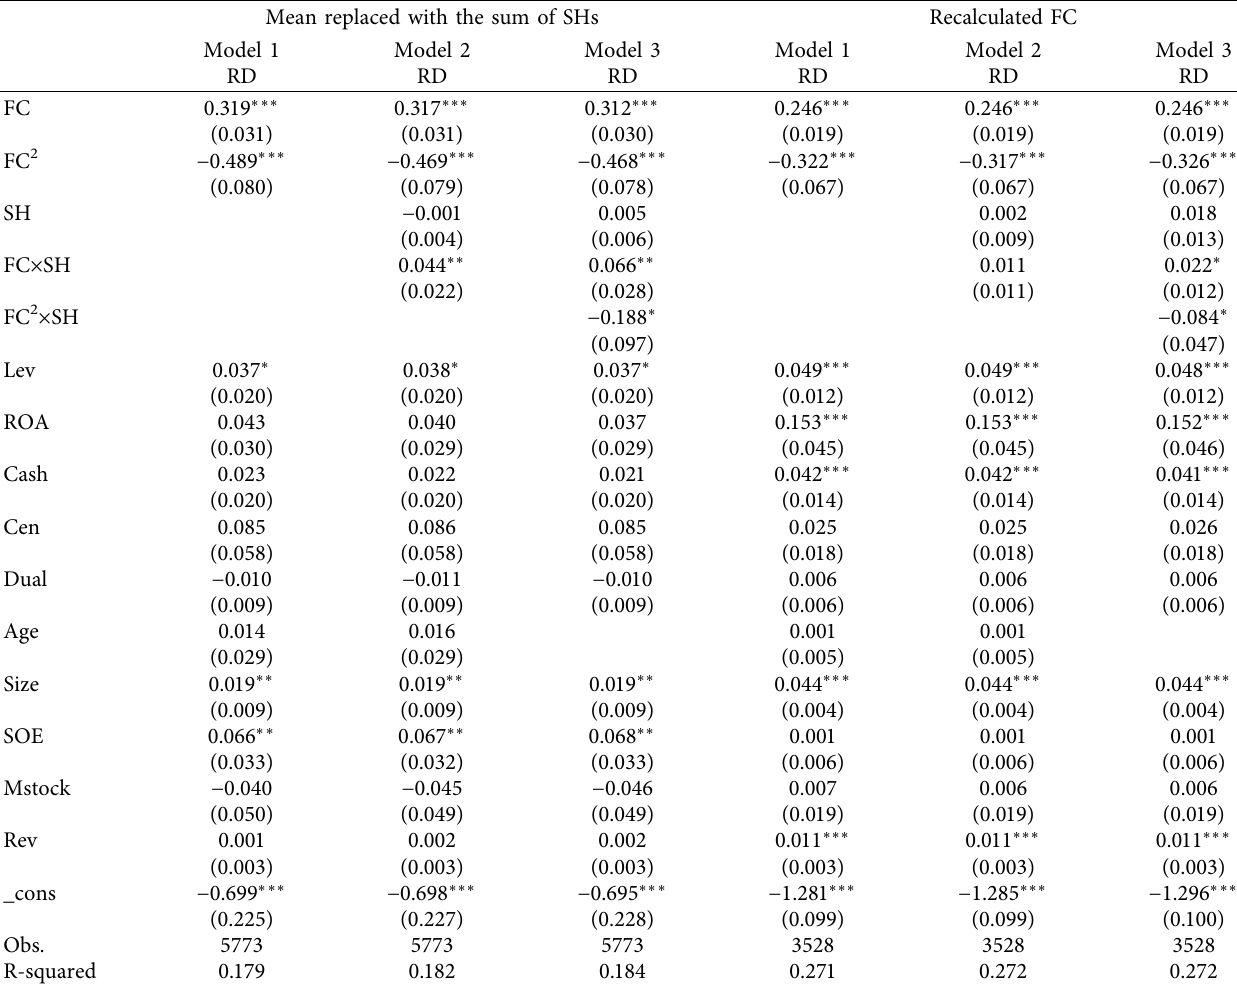
Table 5: Results of robustness test.